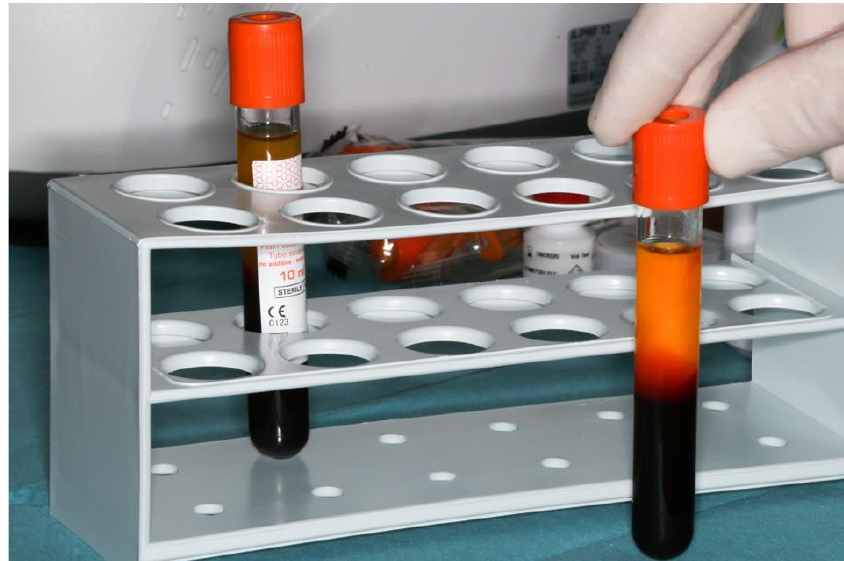
Figure 1. Vacuette with i-PRF preparation.